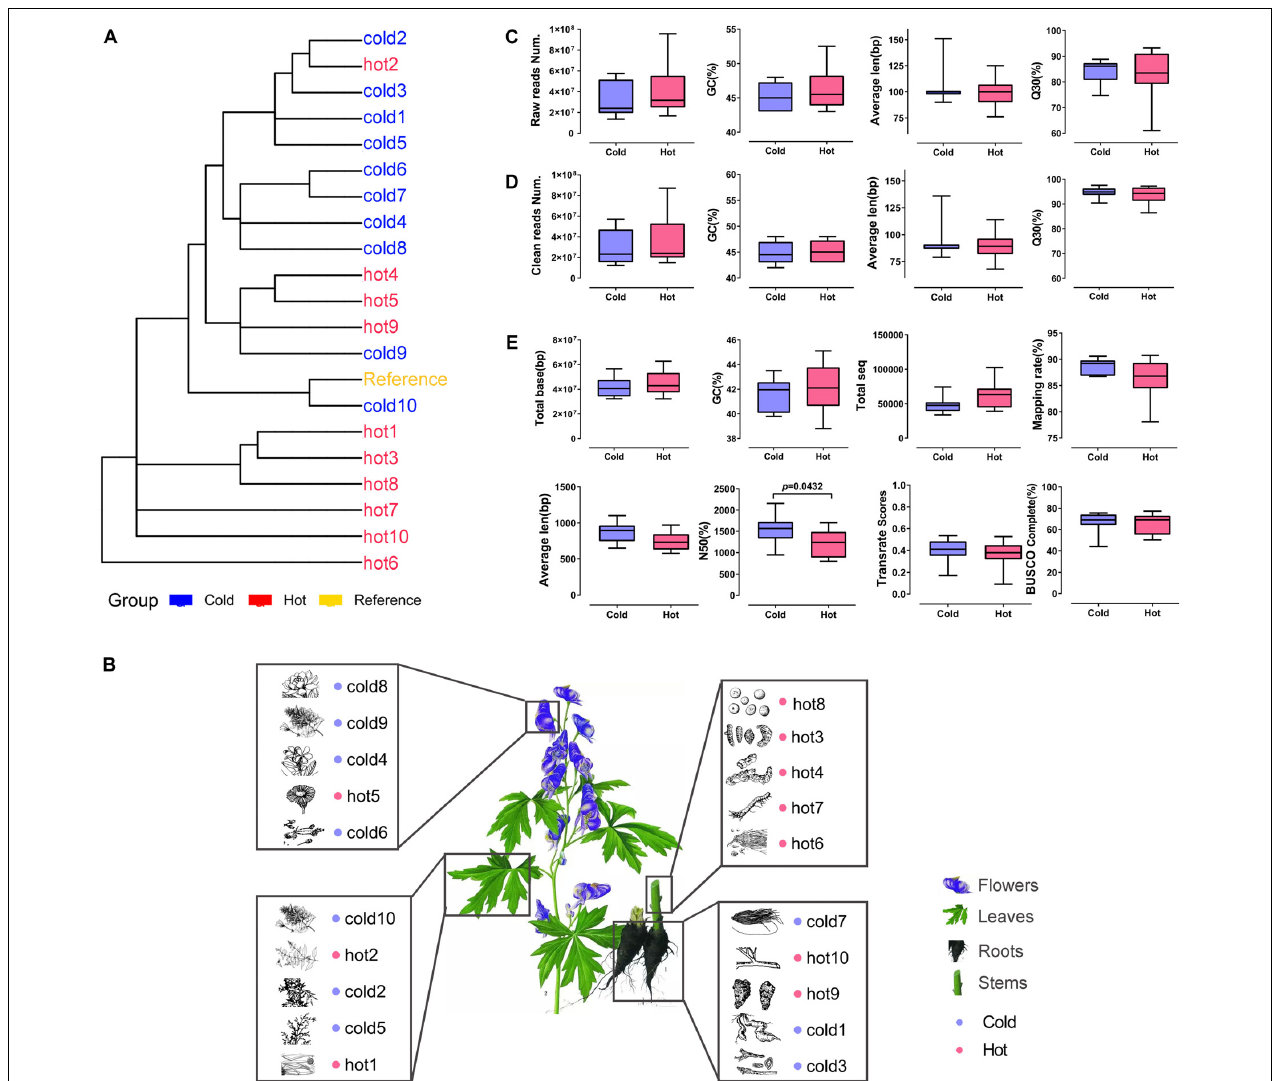
FIGURE 3 | Phylogenetic relationship, organ distribution, qualities of sequencings, and assemblies of 20 samples. Red color indicates HMs with the hot property; blue color indicates HMs with the cold property. (A) Phylogenetic relationship of species used in the study. (B) Organs of selected HMs. The pictures of HMs were cited from Chinese Medicine Dictionary (Shanghai Science and Technology Press, Second Edition). (C,D) Sequencing qualities before and after quality control. (E) Statistics for de novo transcriptome assembly after quality